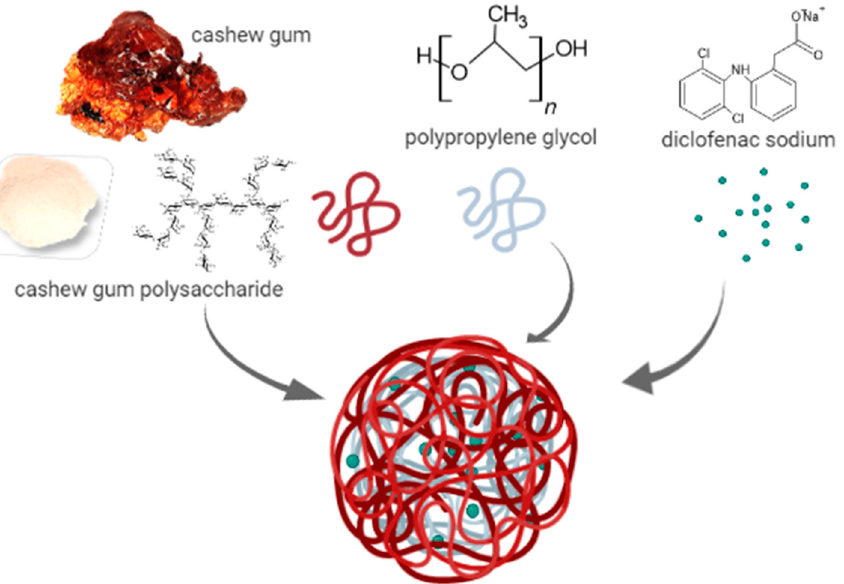
Figure 3. Schematic representation of the polymers and drug organization in the CGP-PPG@diclofenac nanoparticles.